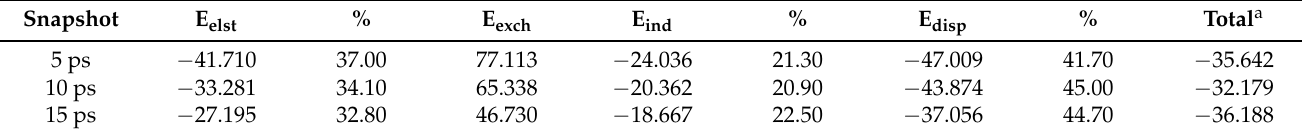
Table 4. Interaction energies between TPM ligand and the amino acids in the most pronounced way involved in its binding. The calculations were performed at the sSAPT0/jun-cc-pVDZ ( Total a ) level of theory; energies are provided in kcal/mol. The percentages provided in the Table correspond to share of each particular component in the total attractive interaction